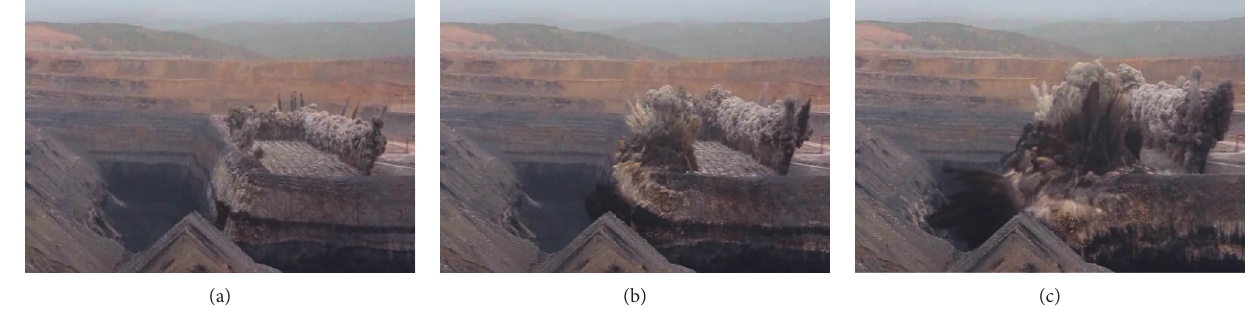
Figure 2: Blasting process (a) Detonation of the presplitting holes. (b) Detonation of the main blasting holes (c) Back-row blasting